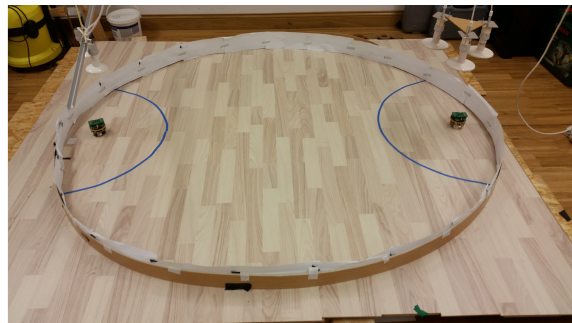
Figure 3: The figure shows the setup of the social seed. Left: local optimum area with a social seed (immobilised robot). Right: global optimum area with a dummy robot to ensure similar circumstances of the two optima areas.